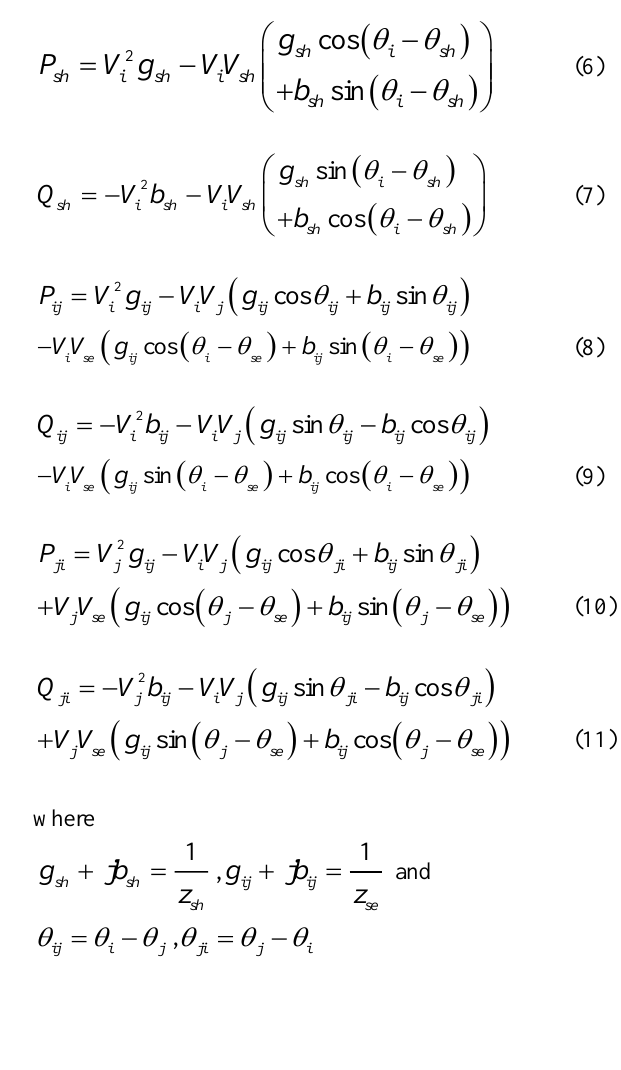
Table 1. Decision matrix to find weak nodes of the